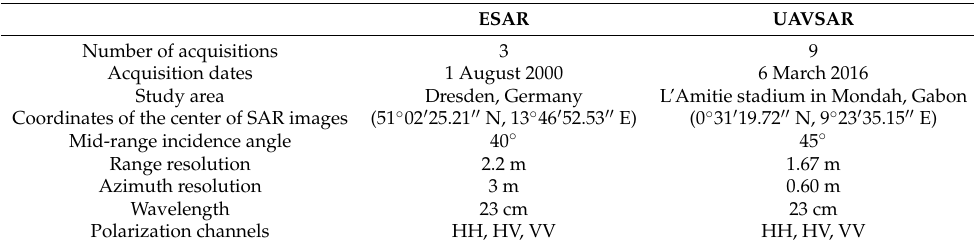
Table 1. Characteristics of the data set